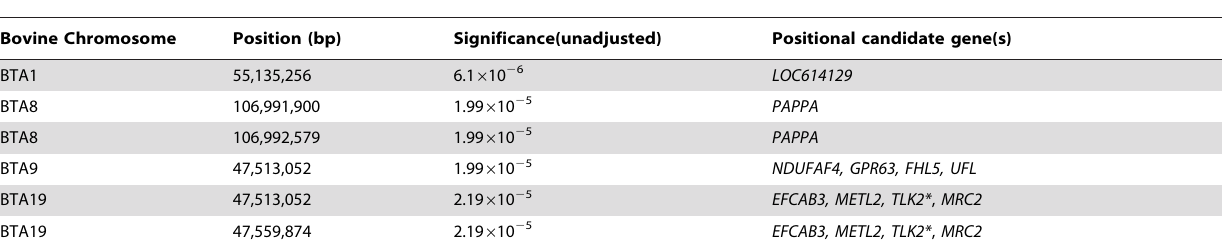
Table 5. SNPs associated with fertility.